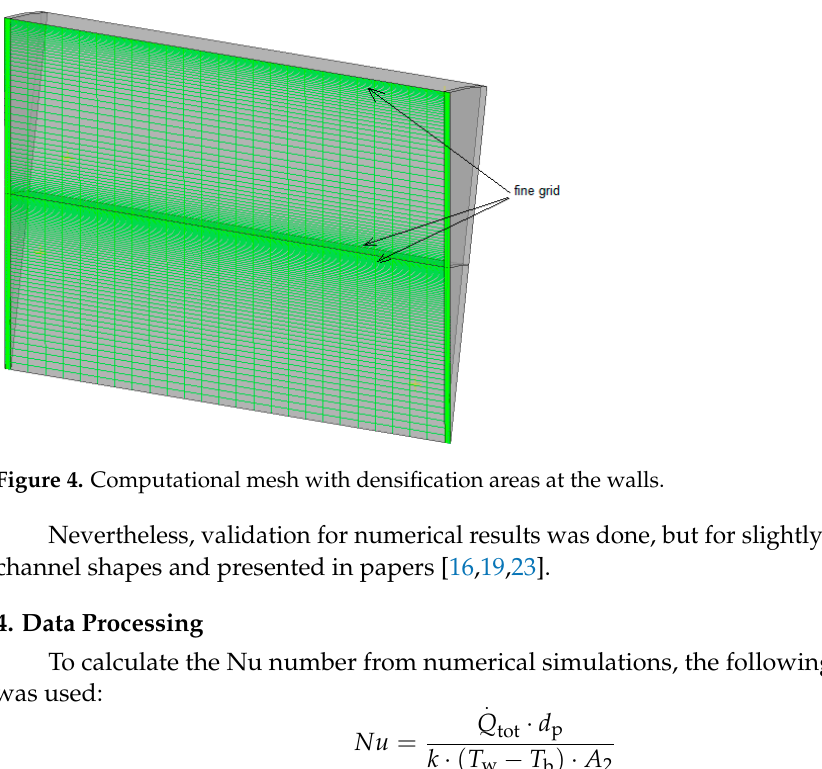
Energies 2021 , 14 , x FOR PEER REVIEW 8 of 20 Table 4. Grid independent test for Re = 18650 and insert diameter D = 0.4. No. of Elements